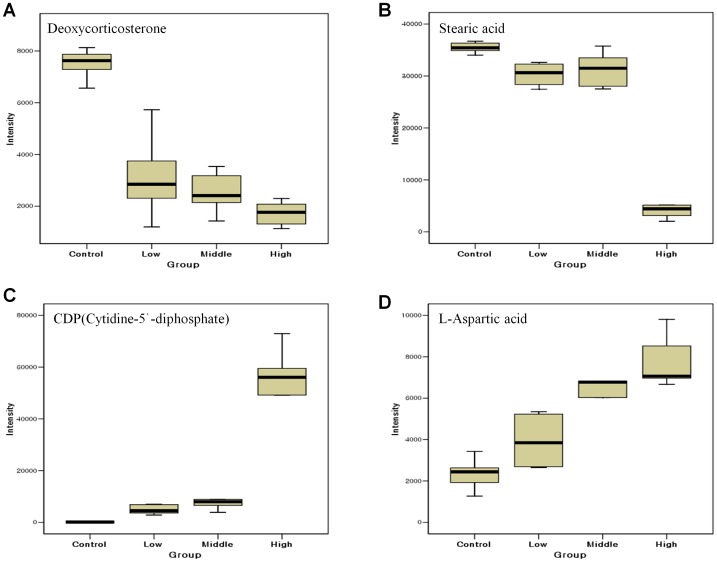
Comparison of the distribution of metabolite intensity levels for control and drug-dosed (low, middle, high) groups.Box plots indicate the distribution of magnitudes of peak intensity levels of key metabolic phenotype in each group. The box is drawn from the 25th to 75th percentiles in the distribution of intensities. The median, or 50th percentile, is drawn as a black horizontal line inside the box. The whiskers (lines extending from the box) describe the spread of the data within the 10th and 90th percentiles.